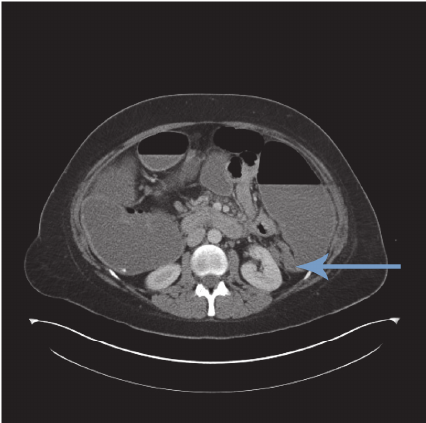
Figure 1: CT scan showing acute pancreatitis and bowel dilatation.